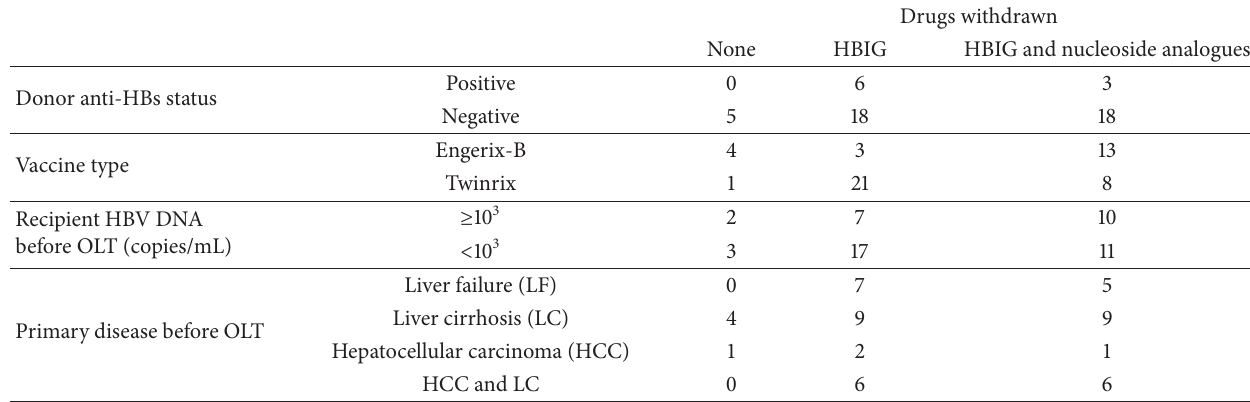
Table 3: Drugs withdrawn according to different